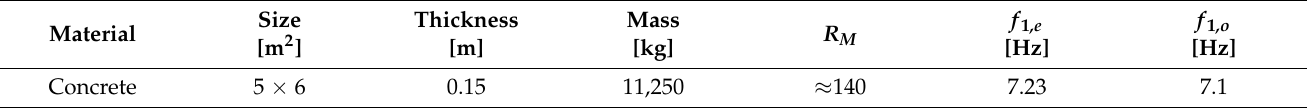
Table 5. Features of selected slab for the present